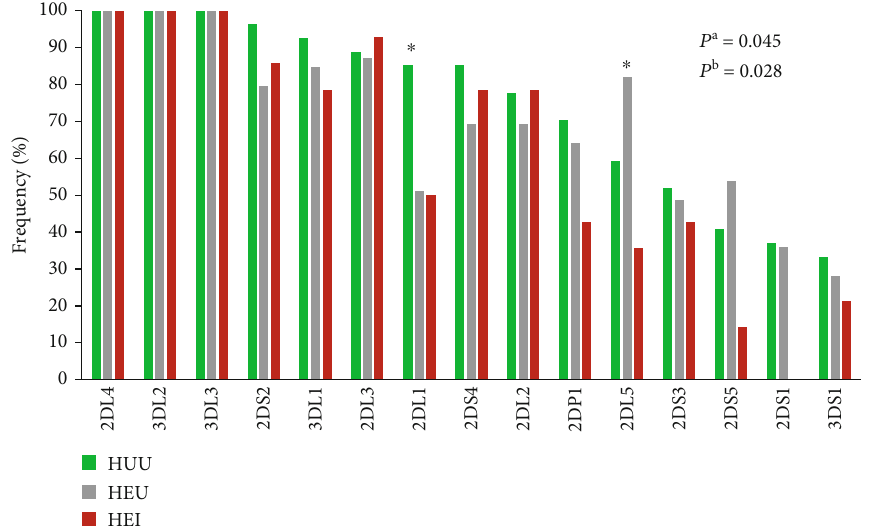
Figure 1: KIR gene frequencies in the study population. P is the P value from the Kruskal – Wallis test comparing all 3 groups. P a is the P value of KIR2DL1 and P b is the P value of